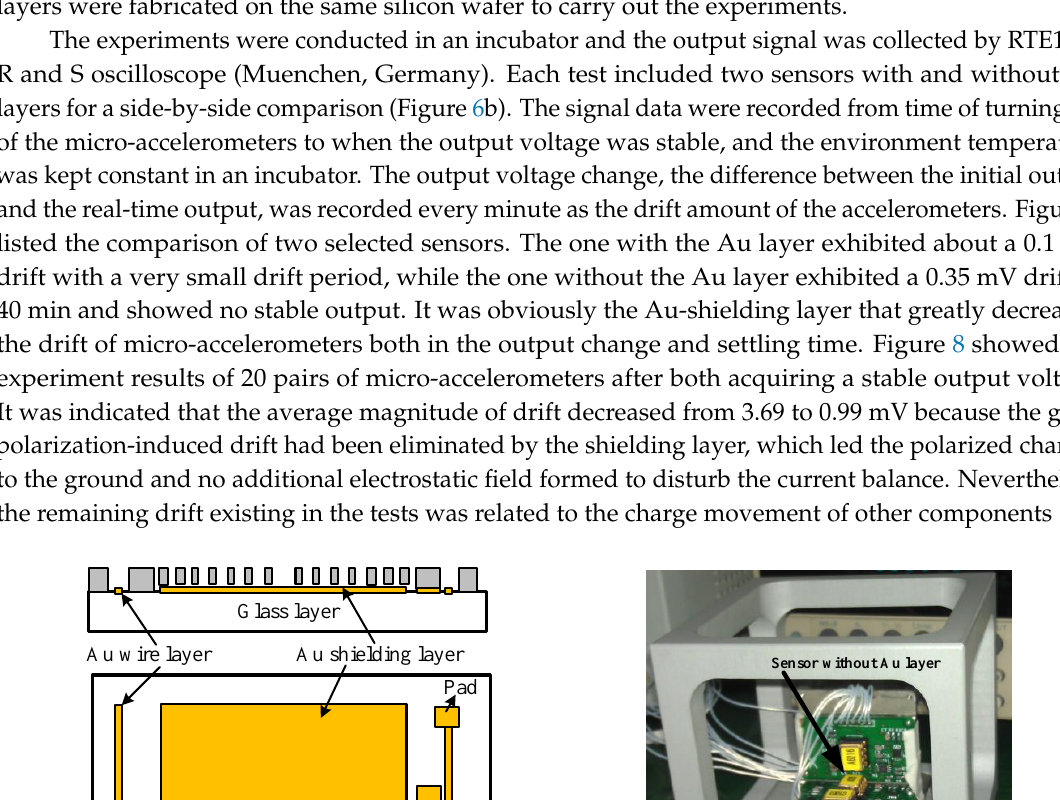
Figure 7. Comparison of sensors with and without an Au layer.